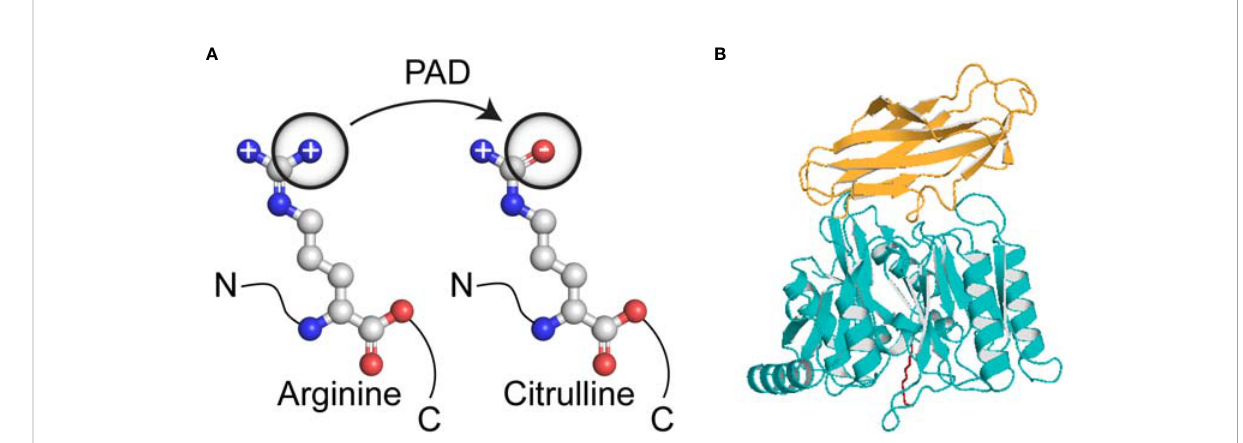
FIGURE 1 Conversion of arginine to citrulline. (A) Biochemical reaction resulting in loss of positive charge on a side chain; (B) The crystallised structure of Porphyromonas gingivalis peptidylarginine deiminase comprises two domains; deiminase domain aa490-360 (yellow) and Ig-like fold aa361-461 (blue). The substrate in the active site was marked as